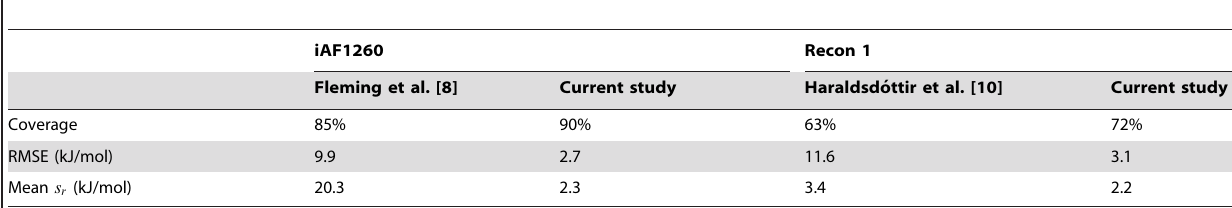
Table 3. Comparison of standard transformed reaction Gibbs energy estimates based on component contributions, to estimates based on previously available data.